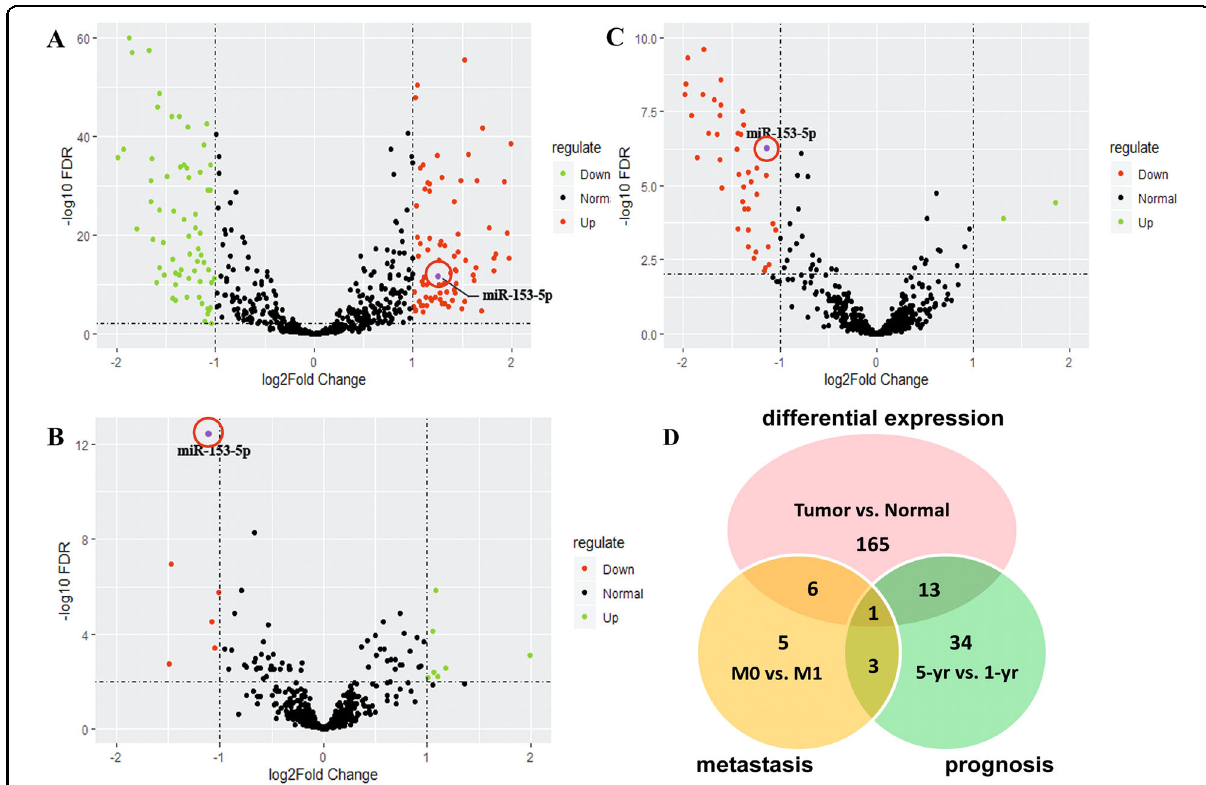
Fig. 1 MiR-153-5p was identi fi ed as a candidate miRNA to promote tumor progression in patients with ccRCC. A – C Volcano plots depicting differentially expressed miRNAs between ccRCC and normal tissue A , between M1 and M0 B , and between <1-year survival (1-yr) and >5-year survival (5-yr) C . D Schematic illustration displayed the overlapping of miRNAs by three volcano